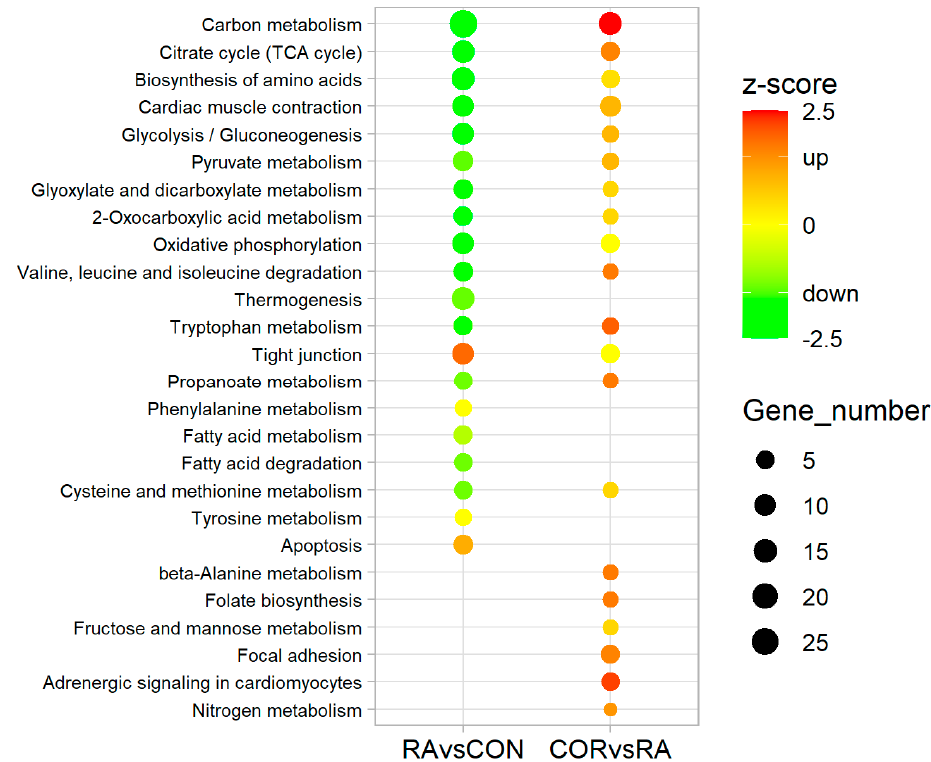
Figure 3. Comparison of enriched KEGG pathways between the RA/CON and COR/RA compari- sons. RA: rheumatoid arthritis induction; COR: coriander treatment. Pathways were selected and ranked by p -value.